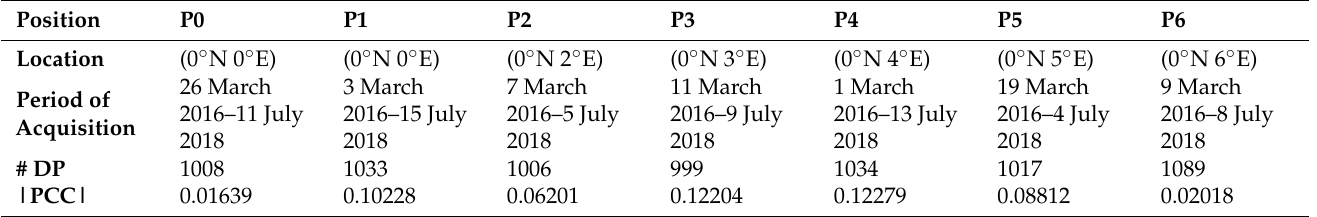
Table 6. Absolute values of Pearson correlation coefficients between SWH_KU_CAL and the TIME feature for seven geographical positions; # DP is the number of data points